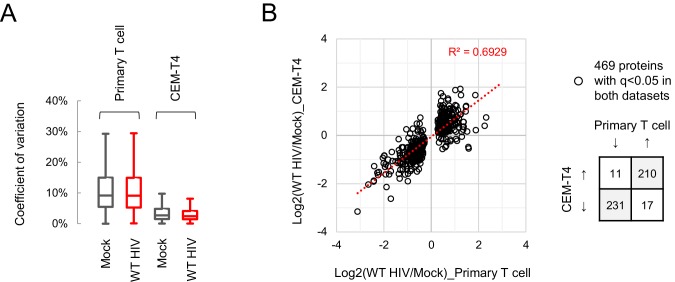
Comparison with HIV-dependent changes in CEM-T4s.(A) Between-sample coefficients of variation (%) for all protein abundances from primary T cells (single time point proteomic experiment, Figure 3A) or CEM-T4s (Greenwood et al., 2016). Boxplots show median, interquartile range and Tukey whiskers for mock-infected (grey) and WT HIV-infected (red) cells. (B) Protein abundances in WT HIV-infected vs mock-infected cells from primary T cells (x axis; single time point proteomic experiment, Figure 3A) or CEM-T4s (y axis) (Greenwood et al., 2016). Fold changes are compared for proteins with q < 0.05 in both datasets. Further details on the CEM-T4 dataset used in this figure are provided in the Materials and methods.